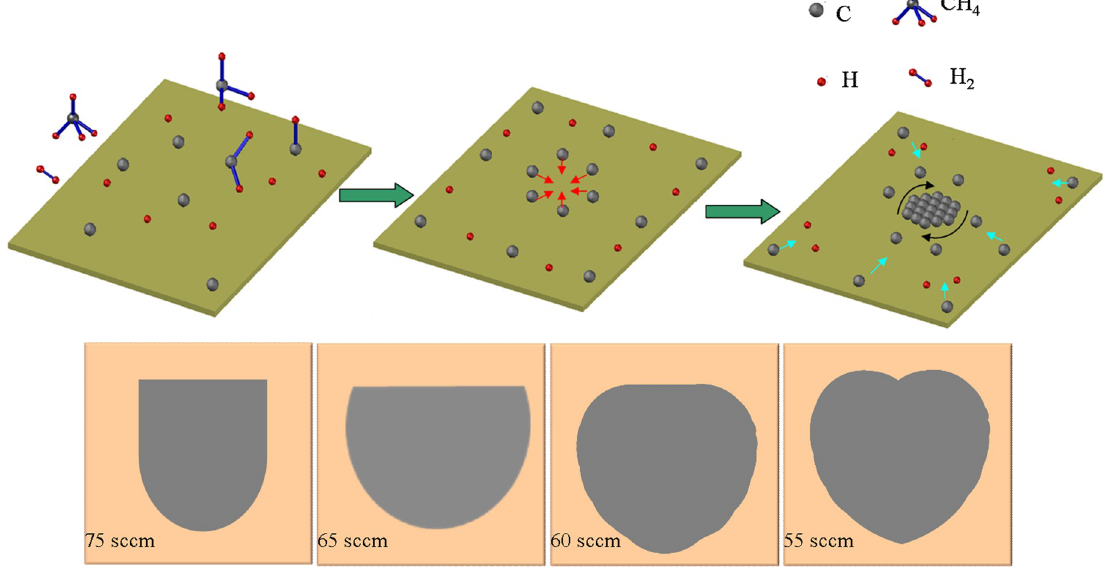
Figure 6. Schematic illustration shows the morphology of the graphene domains on copper foil in different hydrogen flow rates during CVD.